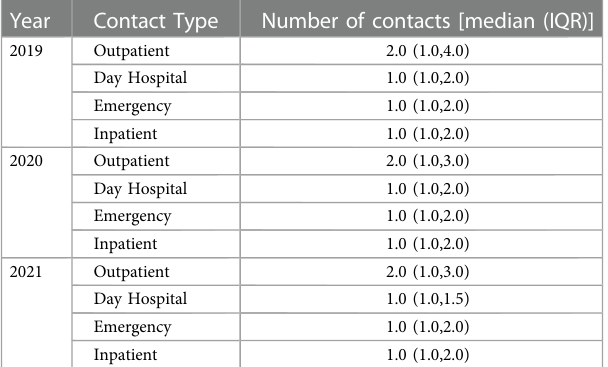
TABLE 2 Contact statistics per year and type of contact for the retrospective cohort 2019 –